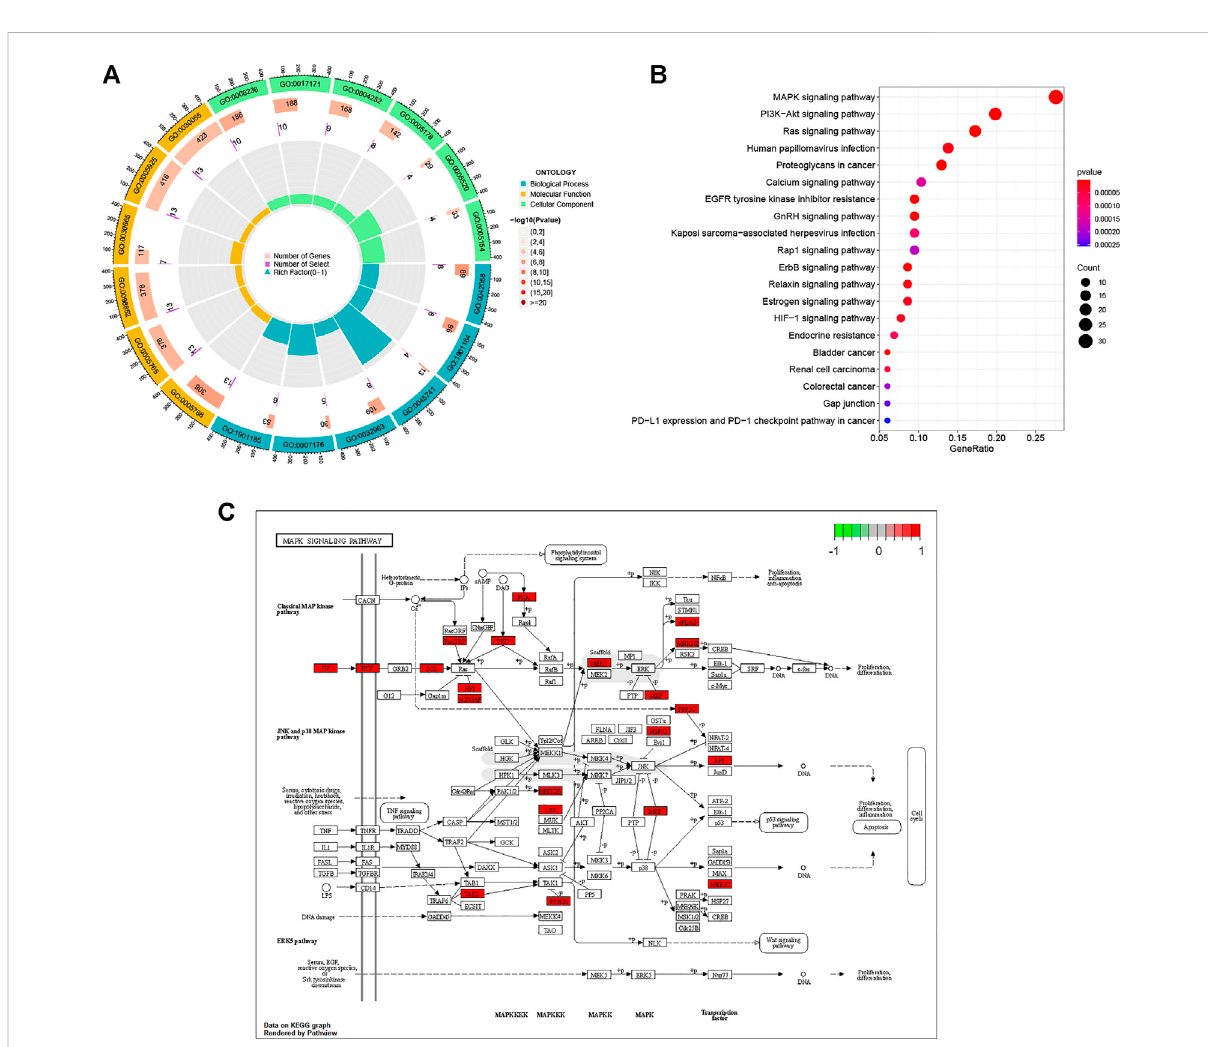
FIGURE 4 Biological Function and Pathway Analysis. (A) GO enrichment analysis of target genes. In the fi gure, terms enriched in the BP category are depicted in blue, terms enriched in the CC category in green, and terms enriched in the MF category in yellow. The p value ’ s cutoff value was set at 0.05. p value is used to rank terms within a category. (B) KEGG enrichment analysis of target gene. (C) Distribution of Target genes in the MAPK signaling pathway. The red box in the fi gure represents Target